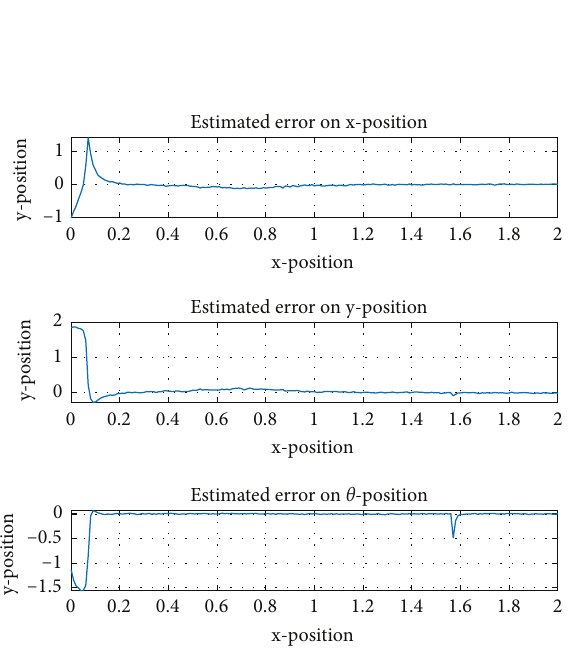
Figure 8: The induced estimation error from the EKF (two landmarks and Gaussian noise).